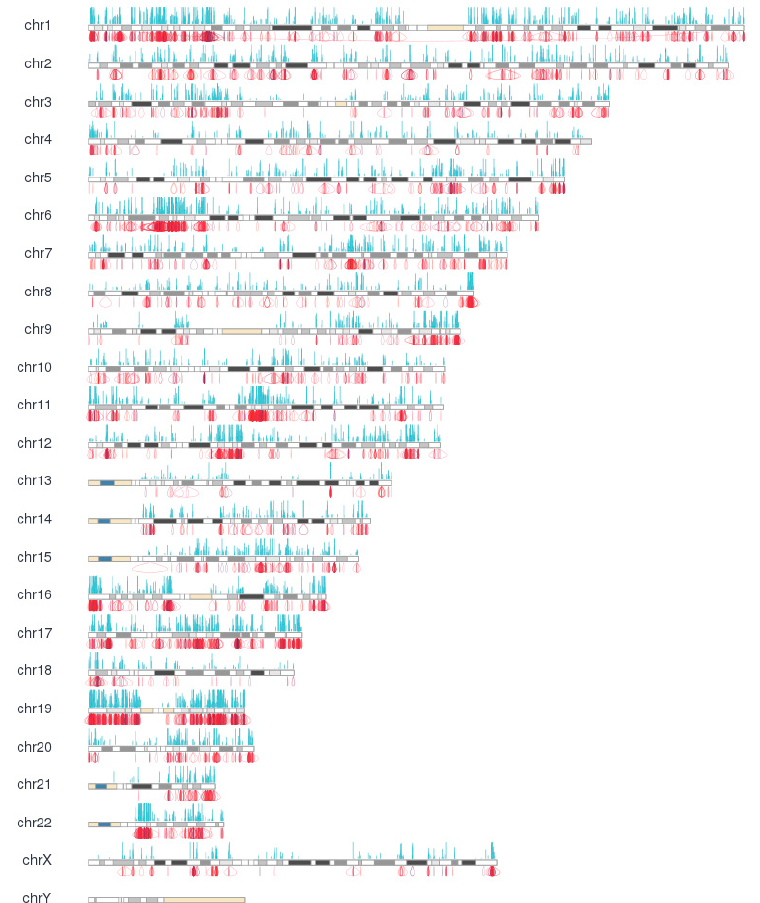
Figure A2. Chromosome view of binding peaks and intra-chromosomal chromatin interactions from human cell line K562.Chromosomes are shown in cytoband format. The blue bars above the chromosomes are the binding peaks, and the heights of the peaks are the coverages of the self-ligation PETs over the peaks. The red curves under the chromosomes are the interaction clusters.